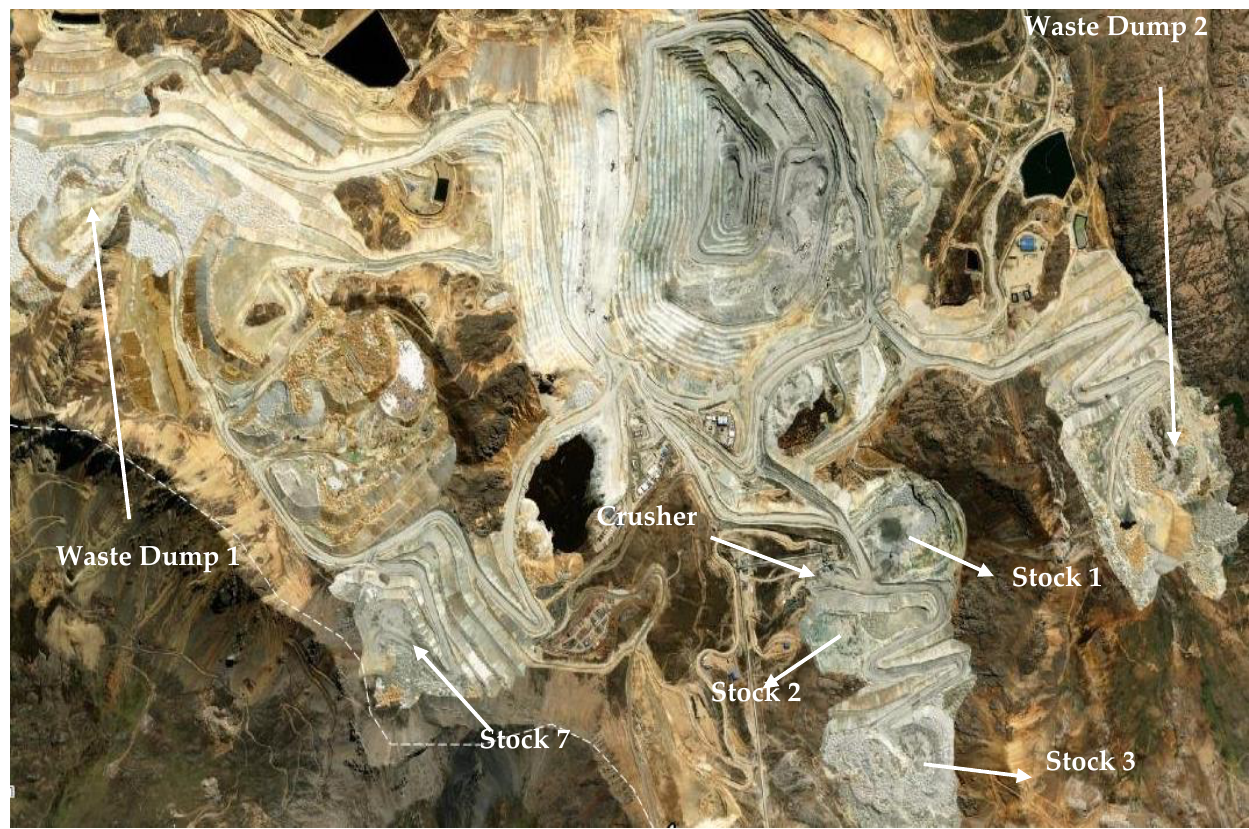
Figure 2. Layout of the Operations Area.